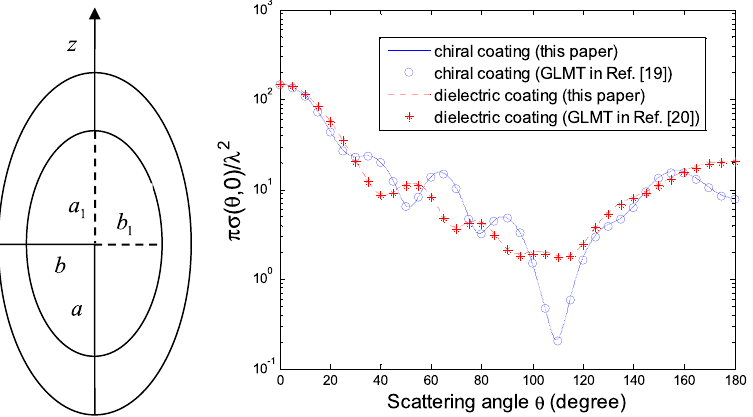
Figure 2. Normalized DSCS πσ ( θ , 0)/ λ 2 for a chiral-coated conducting spheroid ( k 0 a 1 = 6, a 1 / b 1 = 2, k 0 a = 9.14, a / b = 2, ε r = 4, μ r = 1, κ = 0.5) and that for a dielectric-coated conducting spheroid (similarly as the former but κ = 0), both illuminated by a Gaussian beam (TE mode, w